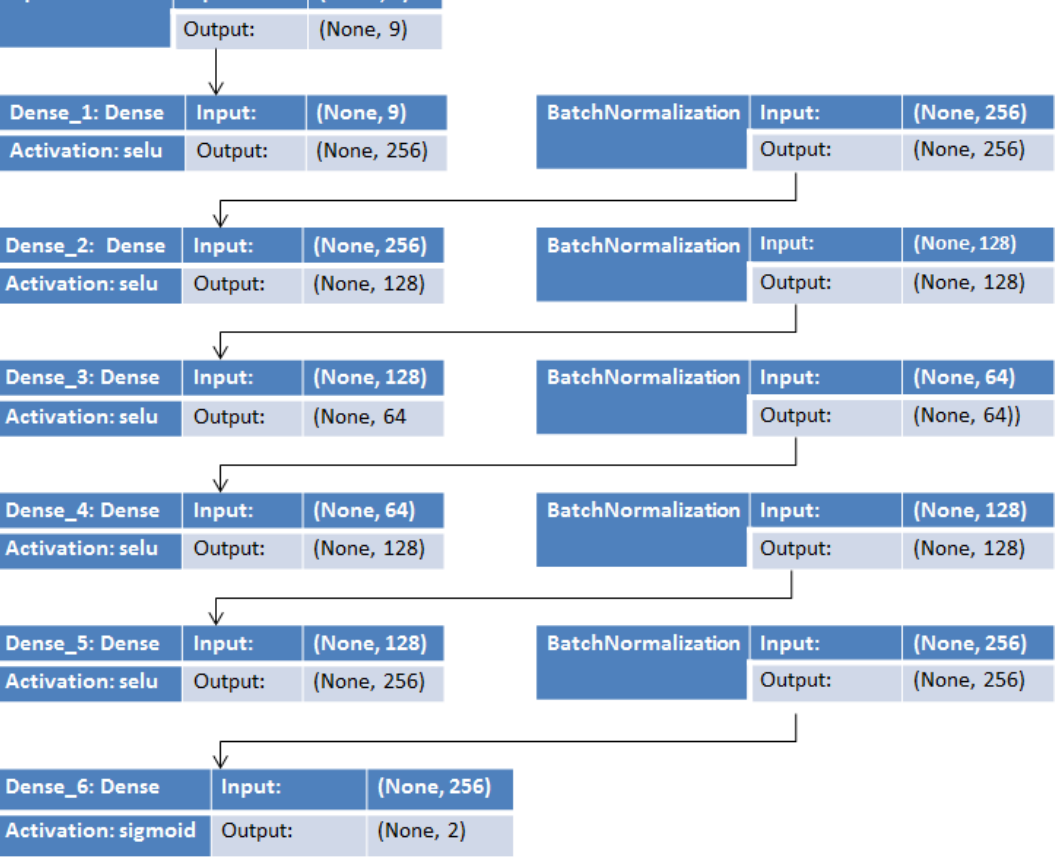
Figure 13. Actual ( x , y ) position based on the dataset.